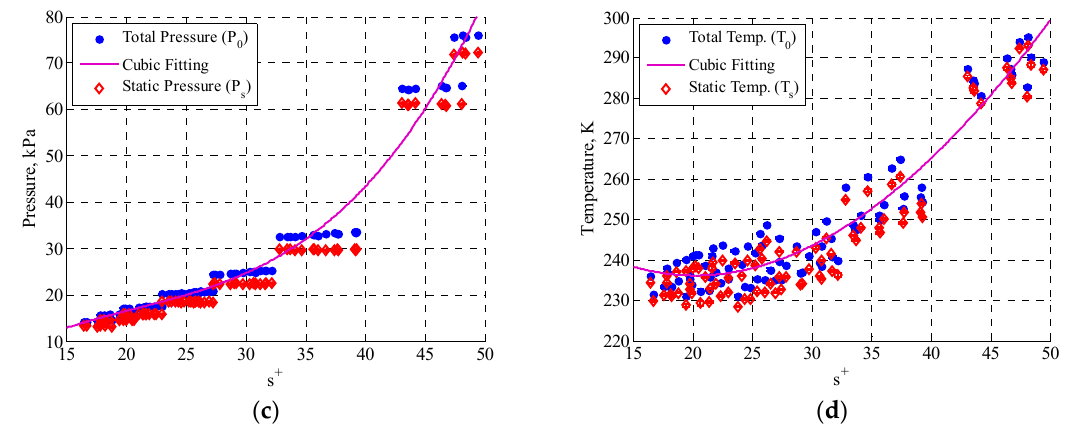
Figure 5. Sensitivities of flight conditions on s + : ( a ) angle of attack; ( b ) yaw angle, ( c ) pressure; ( d ) temperature.